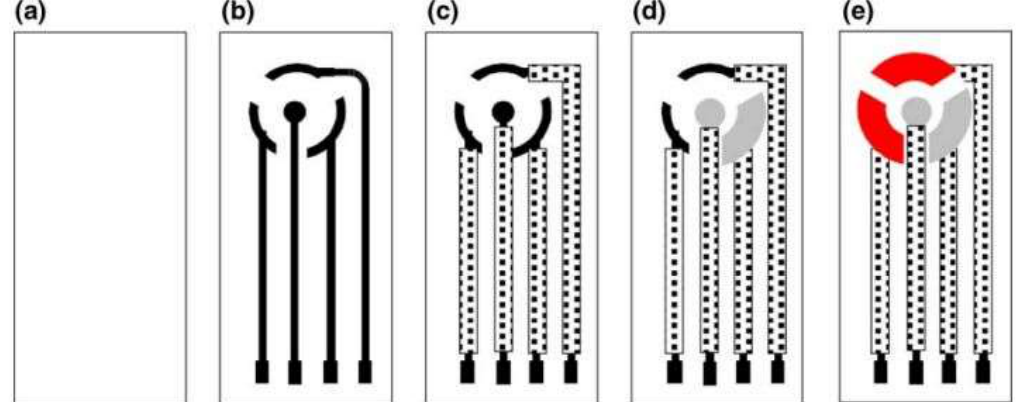
Figure 8. Construction steps for the planar configuration of the screen-printed amperometric transducer. ( a ) PETE support material; ( b ) printing of conducting silver basal track; ( c ) printing of insulation layer; ( d ) printing of Ag/AgCl pads, the central circular pad is the iontophoresis electrode for reverse iontophoresis while the other pad is the reference electrode; ( e ) printing of graphite pads, which serve as the working and counter electrodes [24].